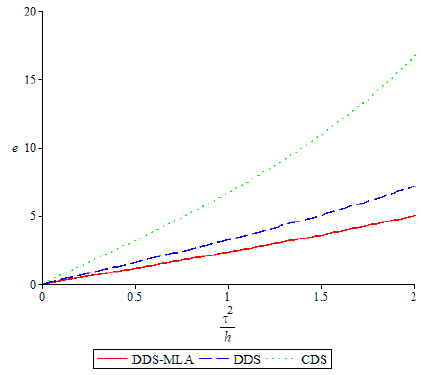
Figure 6. The impact of green efficiency coefficient on green degree.